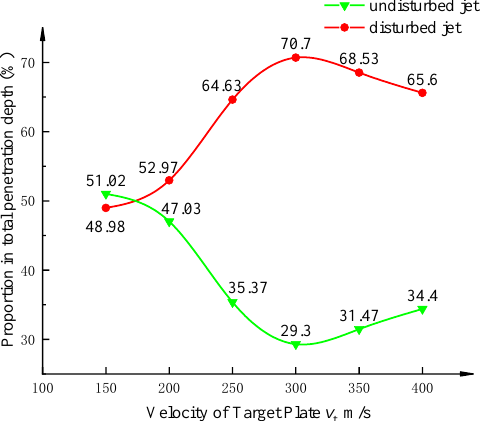
Figure 10. Curve of jet penetration length variation in the perturbed and unperturbed profiles. The penetration depth of the perturbed jet profile initially increases slightly and then decreases. This is because when the moving speed of the target plate is low ( v t ≤ 200 m/s), the effective jet velocity threshold v jk is also low, and the disturbed jet flowing to the bottom of the jet channel still has a certain penetration ability after the interference time, which makes the penetration ability of the disturbed jet increase on the whole, but because the penetration ability of this part is relatively weak, the penetration ability of the disturbed jet is not significantly improved. When the target plate speed is further in- creased ( v t ≥ 300 m/s), because the effective jet velocity threshold v jk is increased, the jet that can effectively penetrate the bottom of the jet crater is continuously reduced, and the penetration length of the disturbed jet is significantly reduced. Combining the regularity of the penetration lengths of the perturbed and unperturbed profiles, the ratio of the two in the total dynamical penetration depth of the jet is plotted in Figure 11.